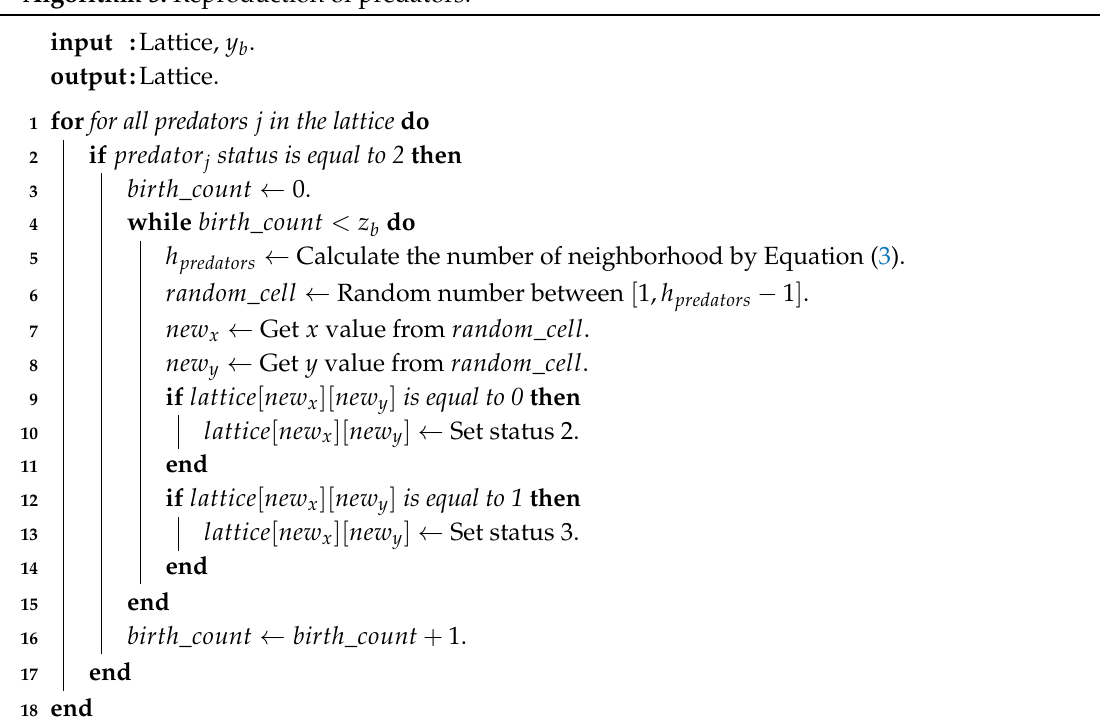
Algorithm 5: Reproduction of predators.